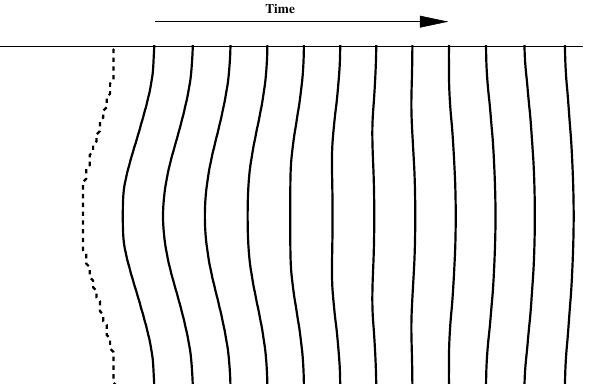
Figure 8. Evolution of an initially perturbed shock (dashed line) in time in an ideal gas medium with γ = 5/3 and Ma = 3.0.